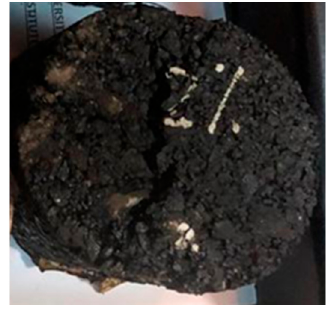
Figure 9. Fatigue-fractured sample.